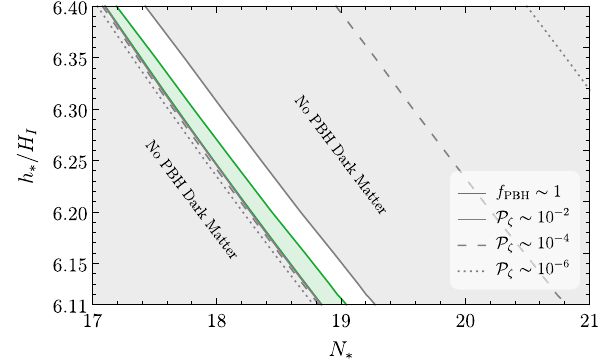
plot we have the same situation as in Ref. [1], with a